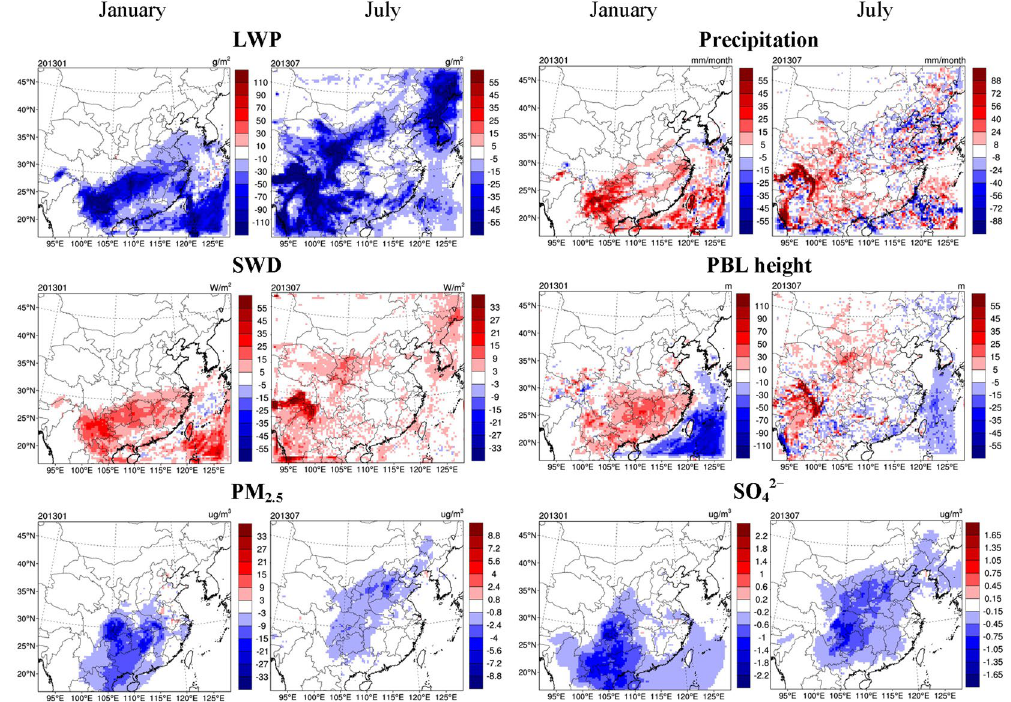
Figure 5. Impact of aerosol-cloud interactions on meteorological variables (LWP, precipitation, SWD, and PBL height) and concentrations of PM 2.5 and SO 42– , relative to a polluted condition with a uniform CDNC of 250 cm − 3 . The results are determined from the scenarios of BASE and PRSC250 (BASE minus PRSC250). This figure is produced using the NCAR Command Language (Version 6.2.1) [Software]. (2014). Boulder, Colorado: UCAR/NCAR/CISL/TDD.